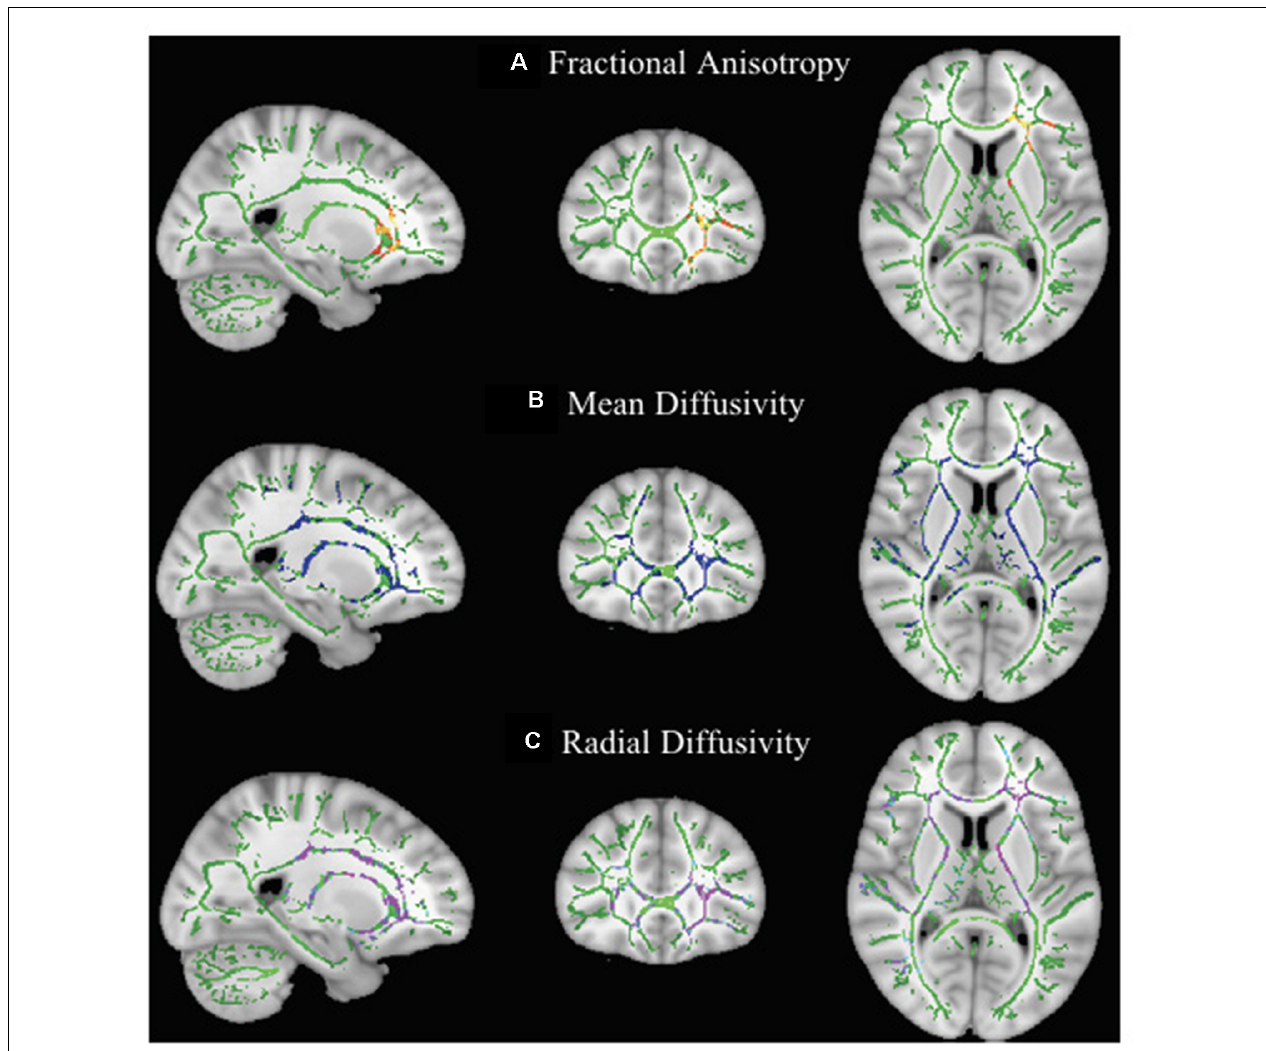
FIGURE 2 | Effect of maturation on DTI parameters in children with DCD. In these images, the white matter skeleton is shown in green and brain structures with altered fractional anisotropy (FA; A ), mean diffusivity (MD; B ), and radial diffusivity (RD; C ) are shown in red, blue, and purple,